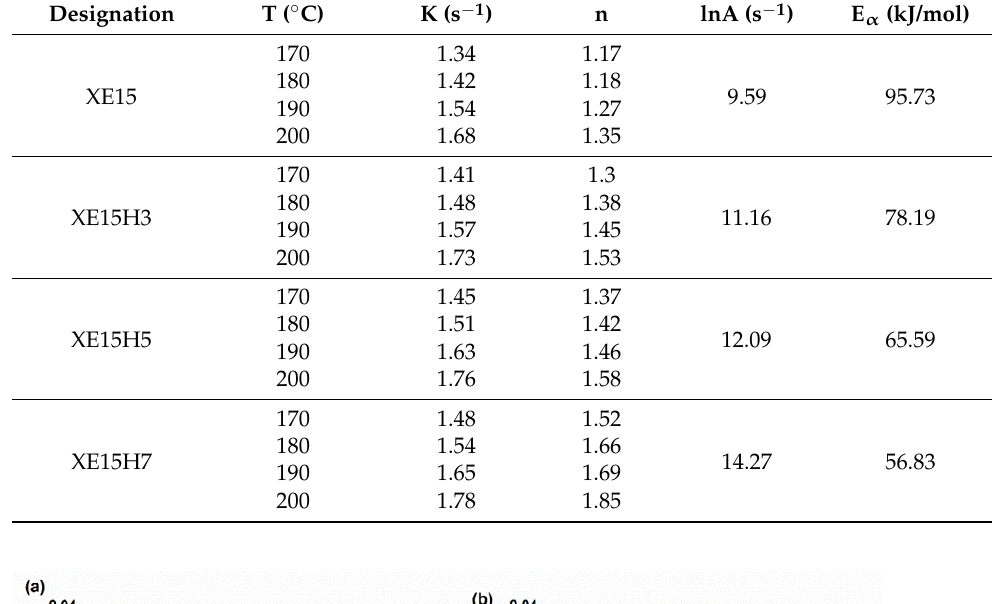
Table 3. Vulcanization kinetic parameters for various XNBR/epoxy/XHNT nanocomposites calcu- lated through using n th order model.